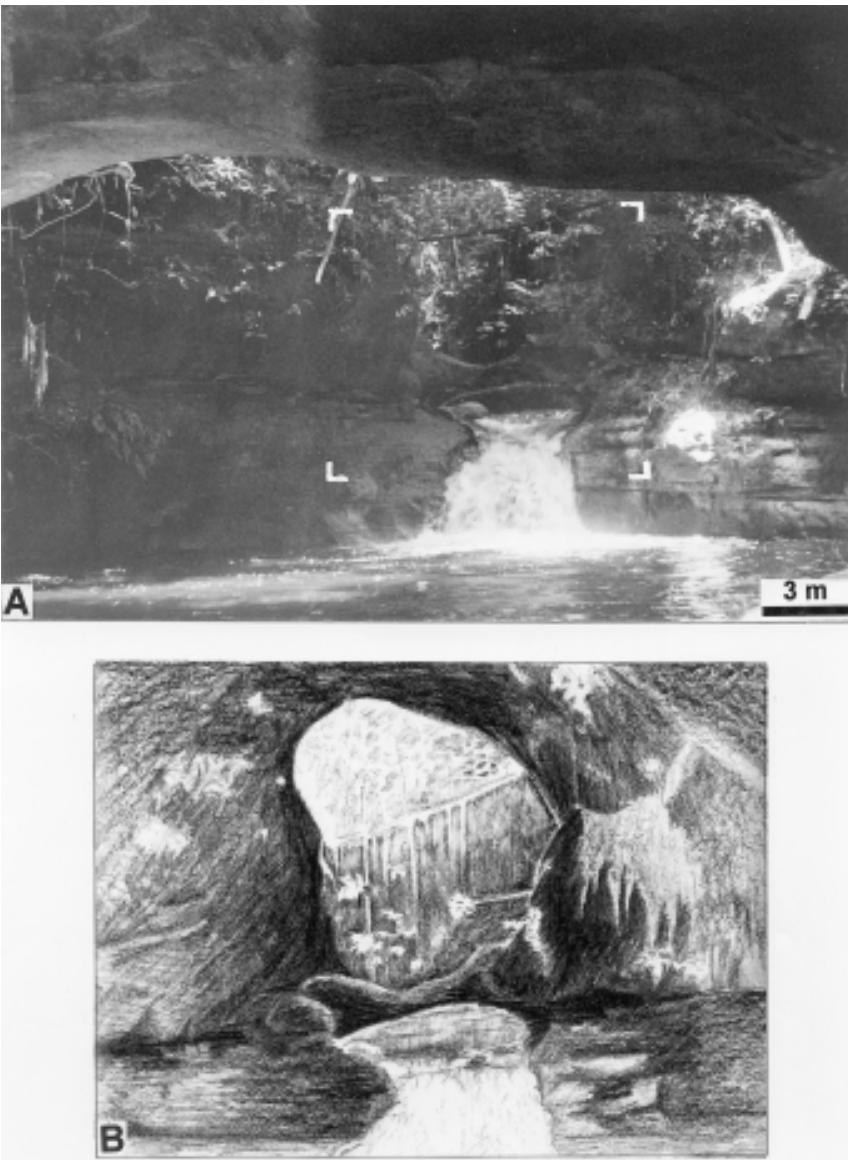
Fig. 7 – Panoramic view of Arcos Waterfall. A) In first plan, cylindrical convexity of quartzarenite (arch) is forming natural bridge on natural swimming pool. Evenly parallel bedding can be observed in at wall. The detached area refers the location of the figure 7B. B) Drawing of abandoned and active outlets (detail of the illustration